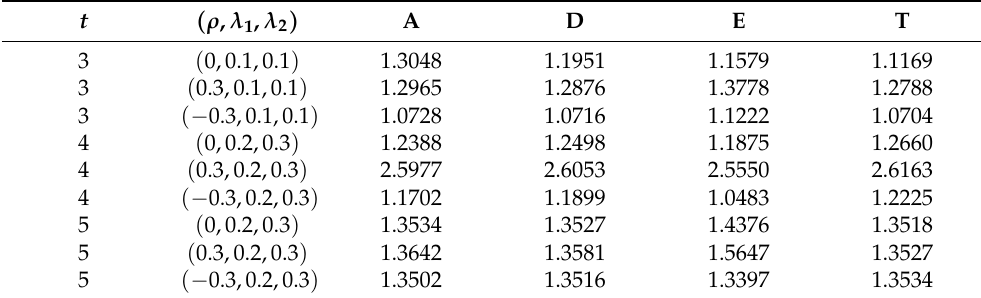
Table 3. Comparison of the Φ p for optimal designs under circular and noncircular setups estimating direct effects with different combinations of ( ρ , λ 1 , λ 2 ) when k =